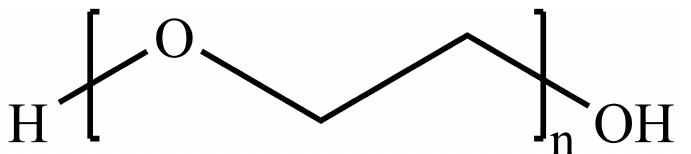
Figure 15. Chemical structure of the non-ionic polymer, poly(ethylene)glycol (PEG). PEG is also widely used in nanomedicinal applications. The n represents the repeating subunits of ethylene